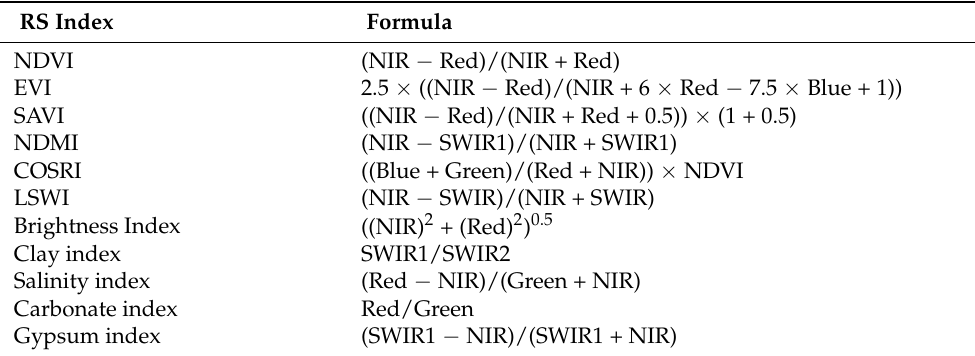
Table 1. Algorithms of the calculation of VIs based on satellite images.